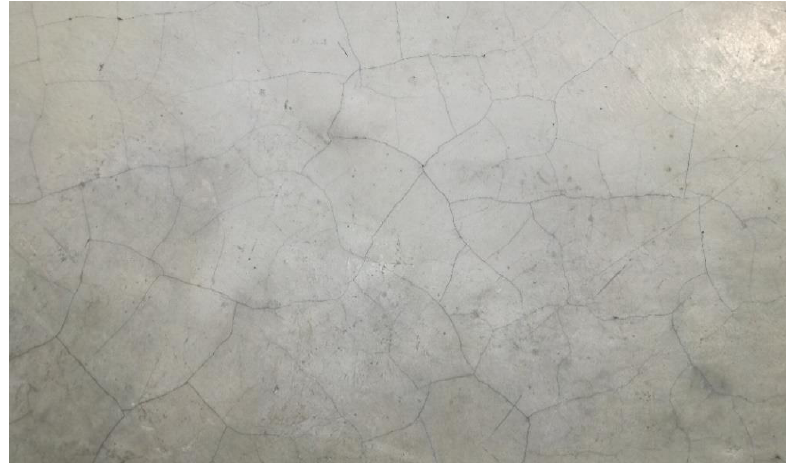
Figure 5. Early-age map cracks that occurred in a newly cast concrete floor slab; these cracks appeared within 14 days of concrete placement; the floor slab was cured by spraying of water.